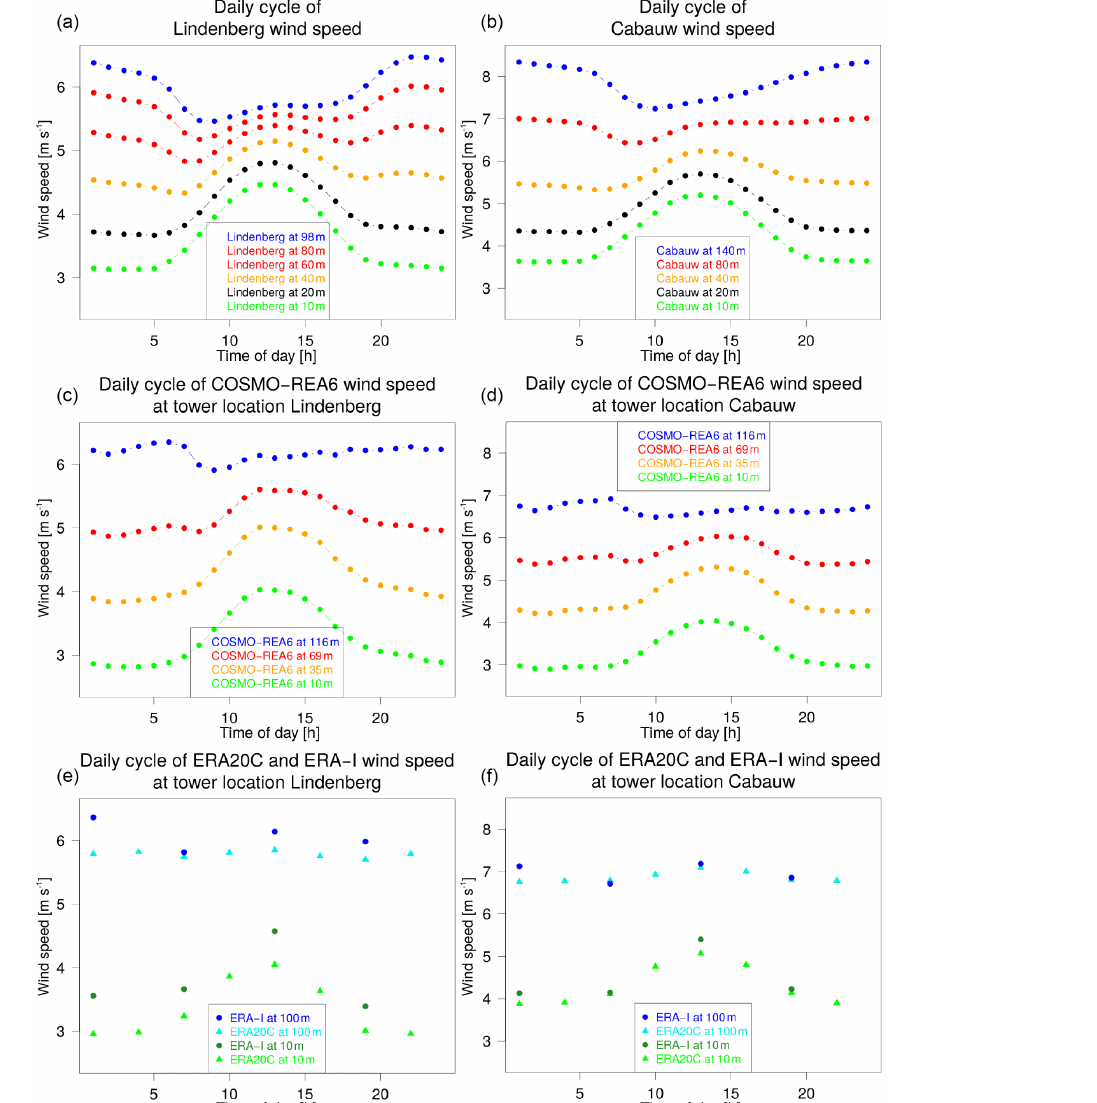
Figure 7. Diurnal cycle of wind speed at the location of Lindenberg (left) and Cabauw (right). Mast measurements are shown at the top, COSMO-REA6 values in the middle, and global reanalyses in 10 and 100m height at the